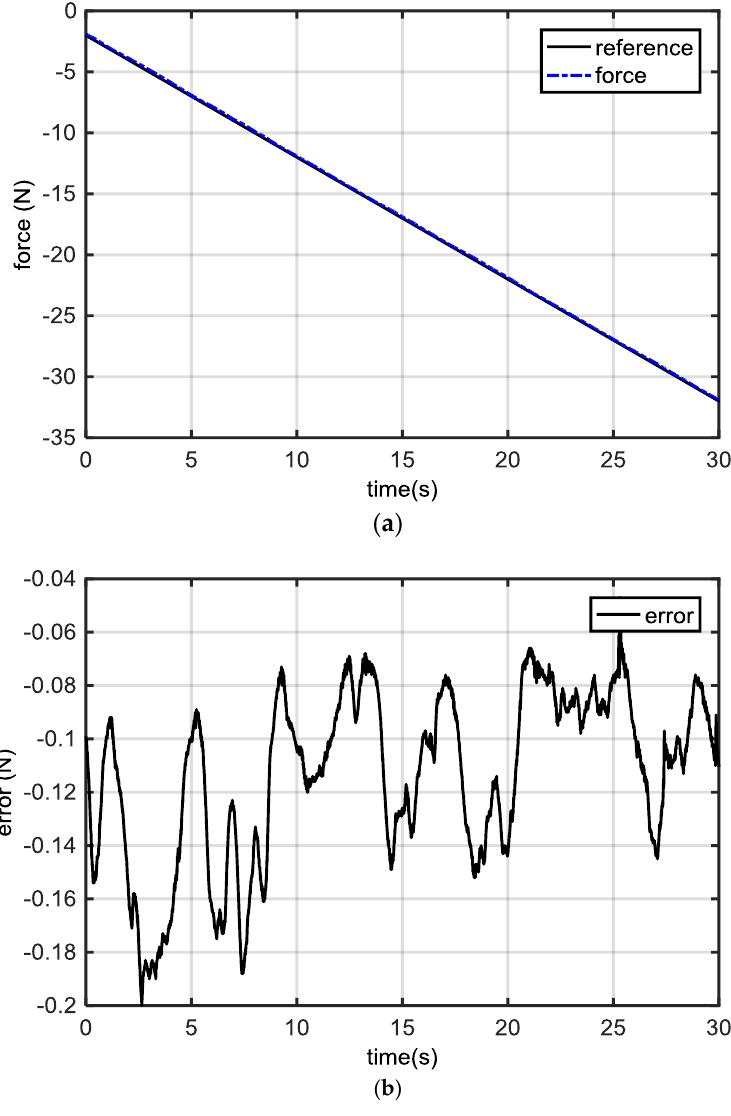
Figure 8. Dynamic response under the constant proportion allocation scheme: ( a ) force profiles; ( b ) error waveforms.